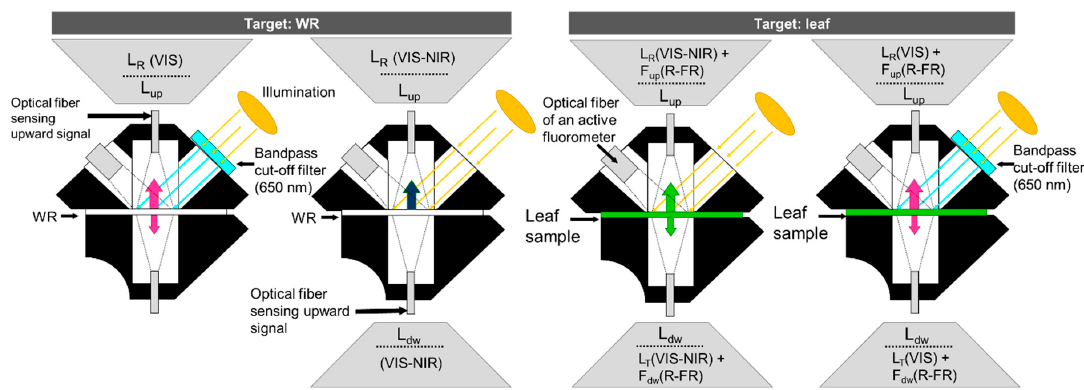
Figure 2. Exemplary bi-directional radiance (L up ( λ ) and L dw ( λ ), W m − 2 sr − 1 nm − 1 ) serial signal acquisition protocol for calculation of irradiance, reflectance, and transmittance in the visible and near-infrared (VIS–NIR) and bi-directional fluorescence (F up , F dw ) in the red and far-red (R–FR) using a white reference (WR) and leaf target clipped inside the FluoWat leaf clip (modified from